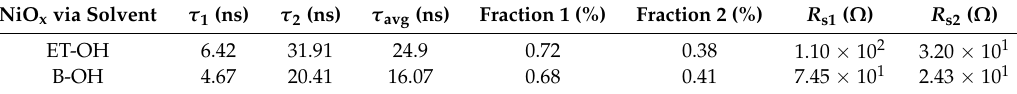
Figure 6. ( a ) Time-resolved transient PL spectra of glass/NiO x via solvent (ET-OH and B-OH)/MAPbI 3 substrate. The steady-state PL spectra were excited at a wavelength of 454 nm. ( b ) Dark impedance measurements of NiO x via solvent (ET-OH and B-OH) based perovskite solar cells at Voc, DC bias. The dark DC bias is applied to obtain the most efficient charge extraction results with the smallest charge transport resistance in a NiO x via B-OH based device. Table 3. Parameters of the TRPL (Time-Resolved Photo Luminescence) spectra and impedance. NiO x via Solvent τ 1